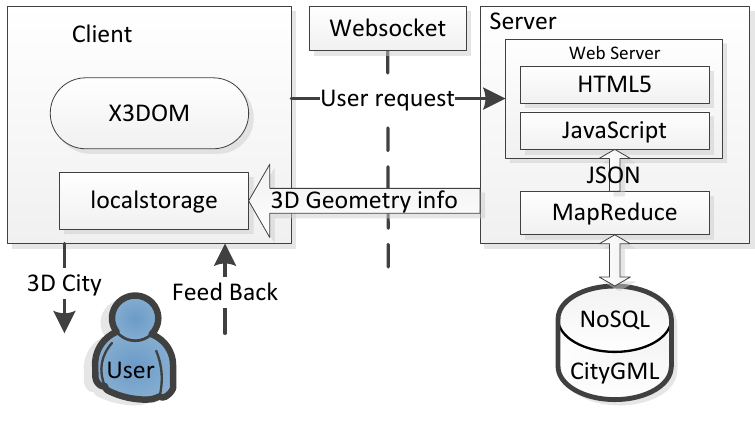
Figure 9. System